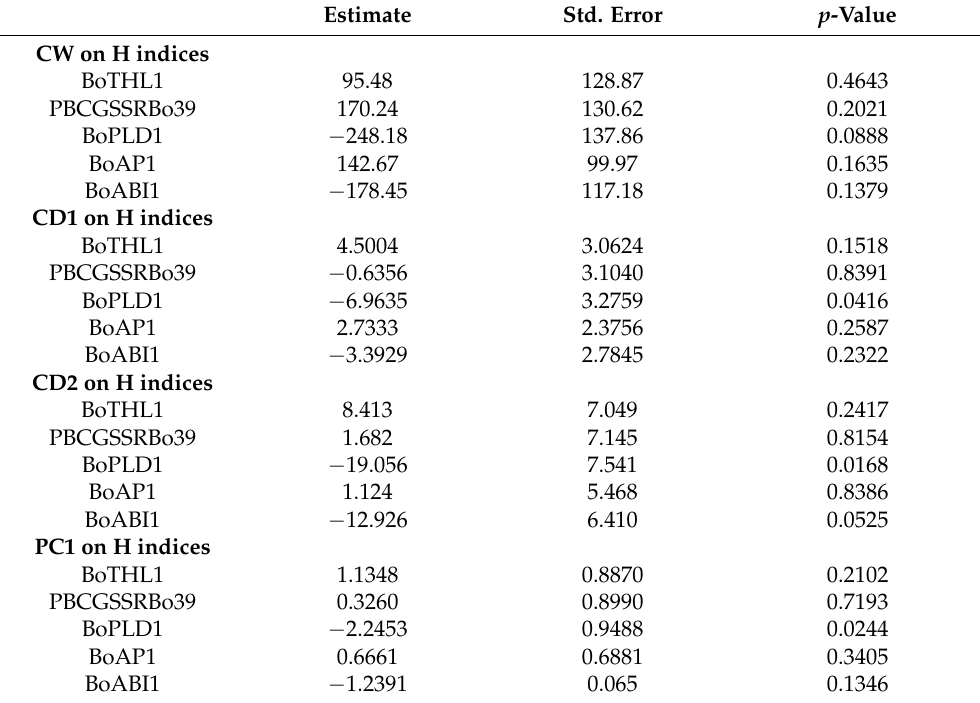
Table 5. Multiple regression on several loci heterozygosity indices of four plant growth parameters: CW—Curd weight, CD1—Curd inflorescence diameter; CD2—Curd Stem thickness and their First Principal Component